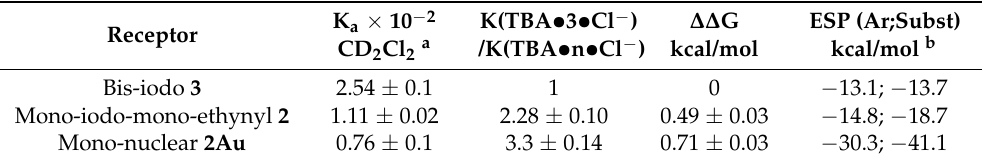
Table 1. Apparent binding constants (K a , M − 1 ) of the ion-paired complexes of receptors 2 , 3 , and 2Au with TBACl in dichloromethane. The value of the binding constants ratio using K(TBA • 3 • Cl − ) as reference and the corresponding ∆∆ G are also listed. ESP values at the center of the phenyl ring and at the para -substituent (ESP 1 ; ESP 2 ) are